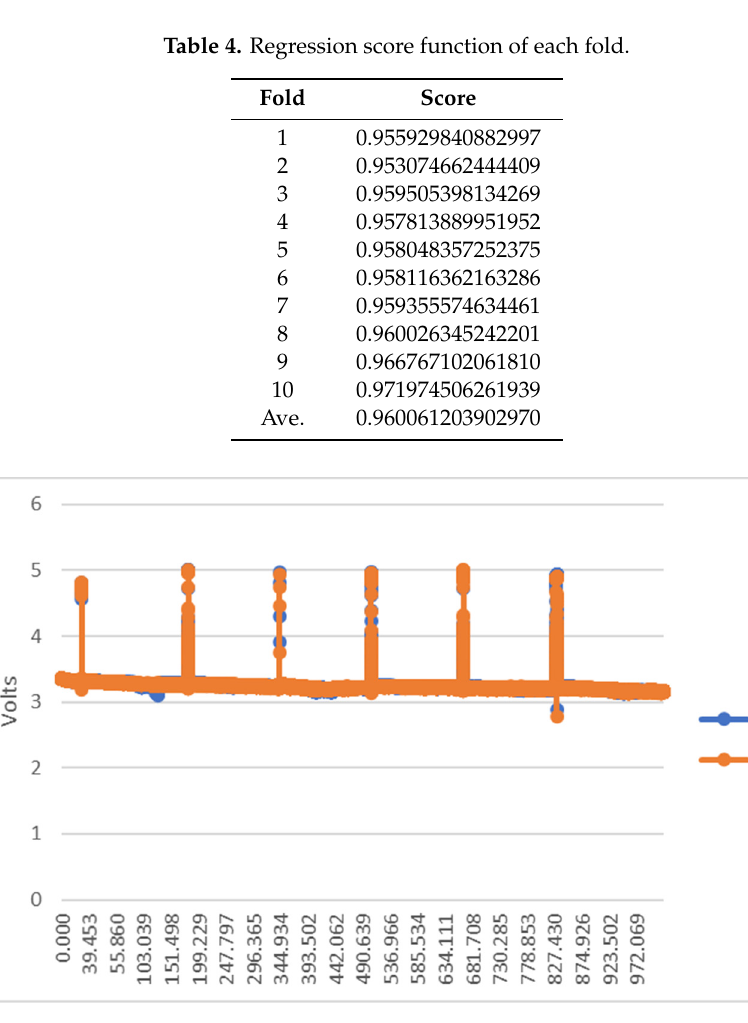
Table 4. Regression score function of each fold.